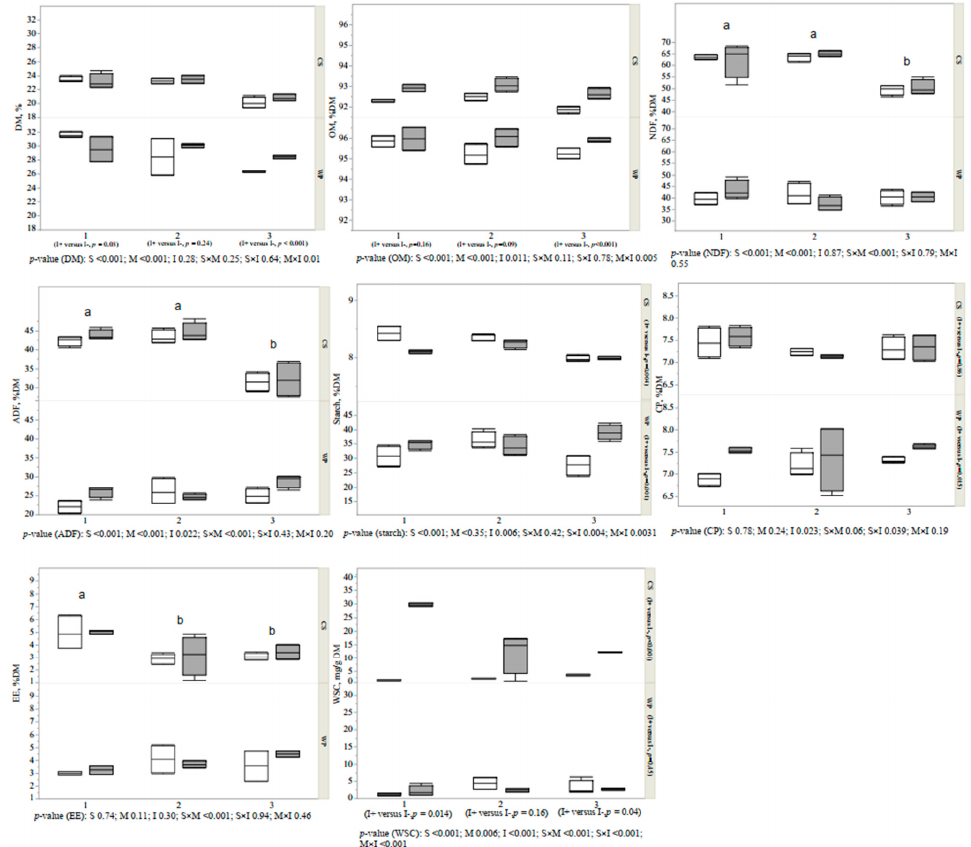
Figure 1. Effect of substrate, time after ensiling, and inoculation of Lactobacillus plantarum on chemical composition of silage (n = 4). CS, sweet corn stover; WP, sweet corn whole plant. Sampling time points (months after ensiling) are scattered along the x axis. Boxes filled in gray indicate inoculation with Lactobacillus plantarum . Horizontal lines inside the boxes indicate the median, upper and lower lines of boxes indicate upper and lower quartiles, respectively, and whiskers indicate the maximum and the minimum. p -values for the following effects are provided in legends below the graph: M, Months after ensiling; S, substrate; I − , not inoculated; I+, inoculated; S × M; interaction between substrate and month; S × I; interaction between substrate and inoculation; M × I; interaction between month and inoculation. DM, dry matter; OM, organic matter (100% minus ash content); NDF, neutral detergent fiber; ADF, acid detergent fiber; CP, crude protein; EE, ether extract; WSC, water soluble carbohydrates. ab Unlike-lower case letters within a substrate differ ( p < 0.05).